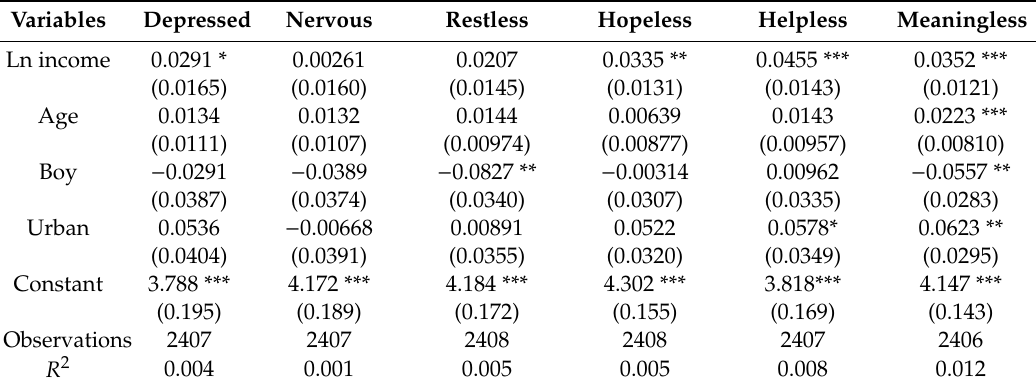
Table 3. Regression results of children’s emotional wellbeing as a function of family